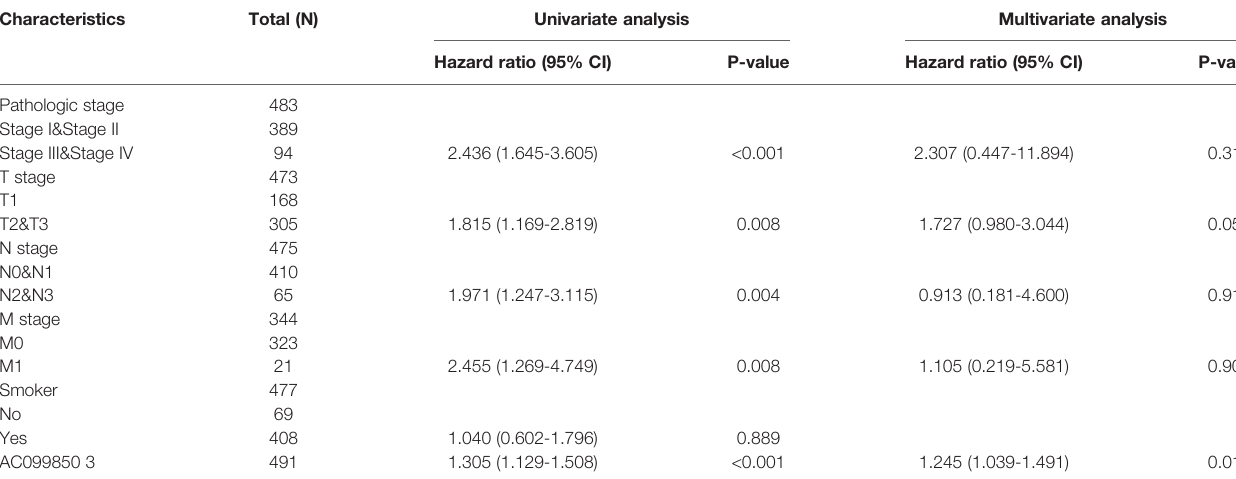
TABLE 4 | Univariate and multivariate Cox regression analyses of different parameters on DFS.